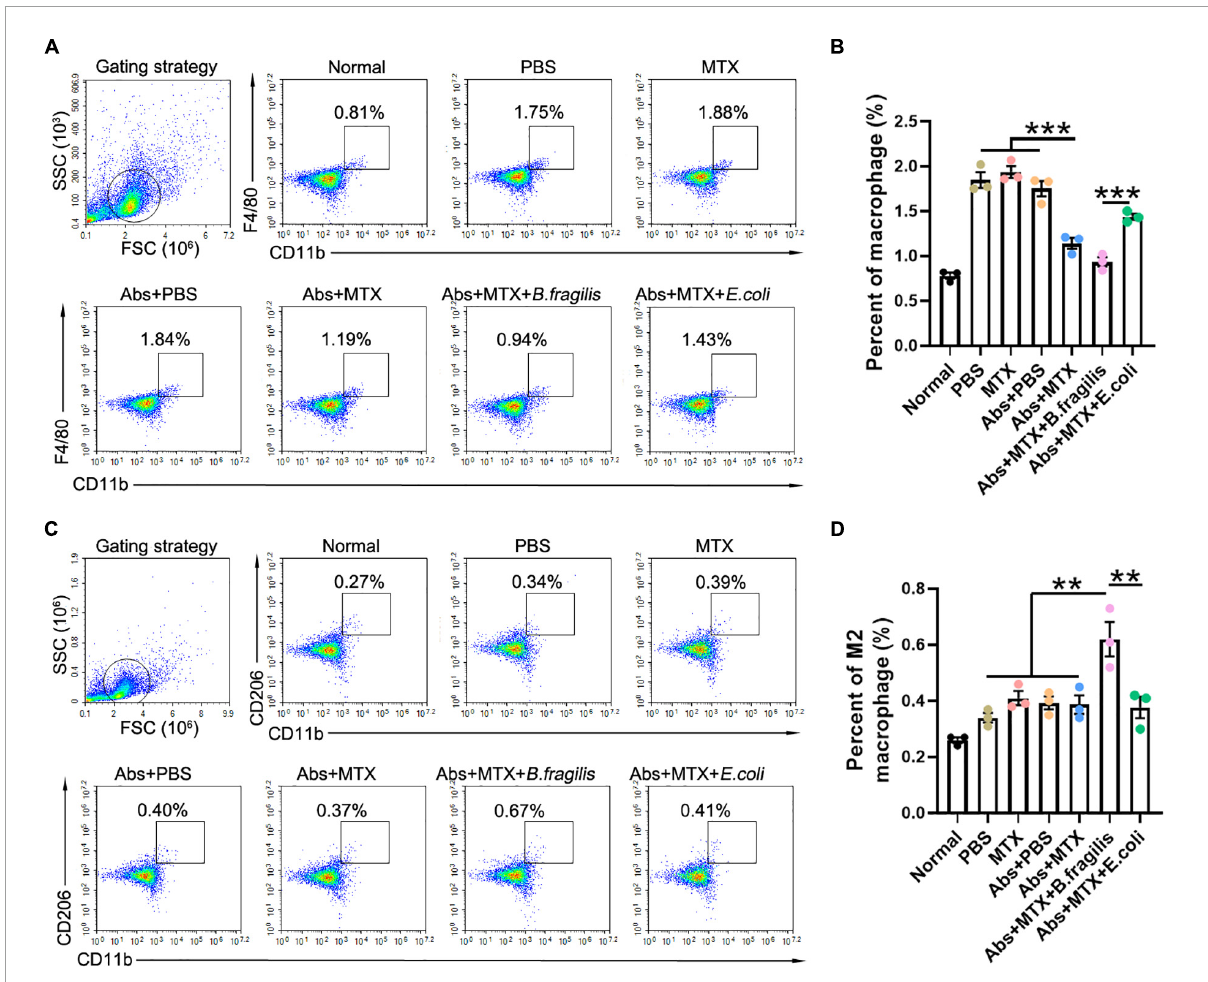
FIGURE3 Bacteroides fragilis alters the polarization of macrophage. (A–D) FACS analysis of splenic cells. Percentages of (A,B) macrophages and (C,D) M2 macrophages ( n = 3). Data are presented as the mean ± SEM. ** p < 0.01, *** p < 0.001. Abs,